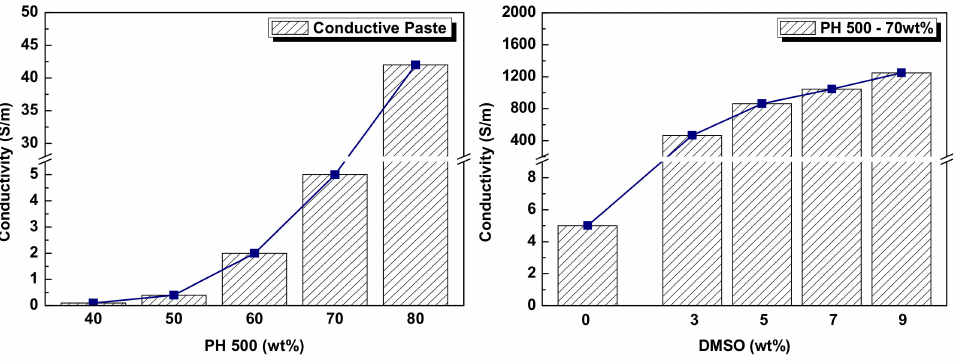
Figure 3. Conductivity of conductive paste measured by Clevios PH 500 and